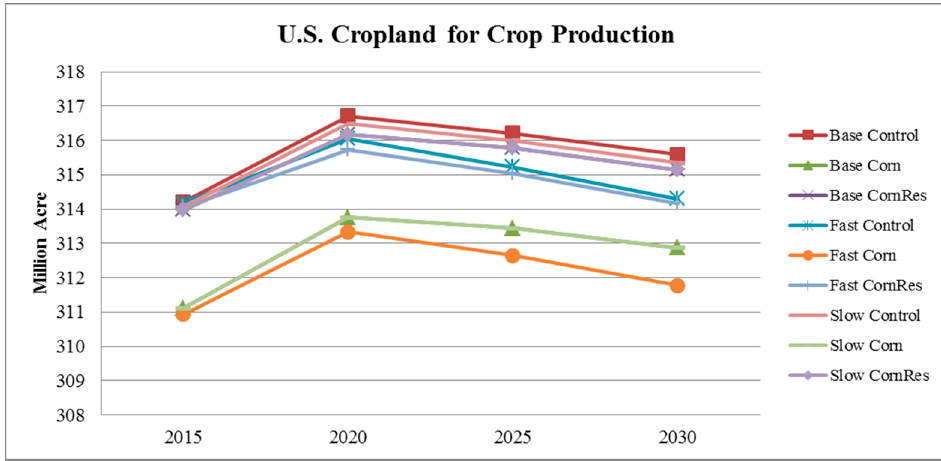
Figure 4. Average U.S. cropland for crop production projection during 2015 to 2030.